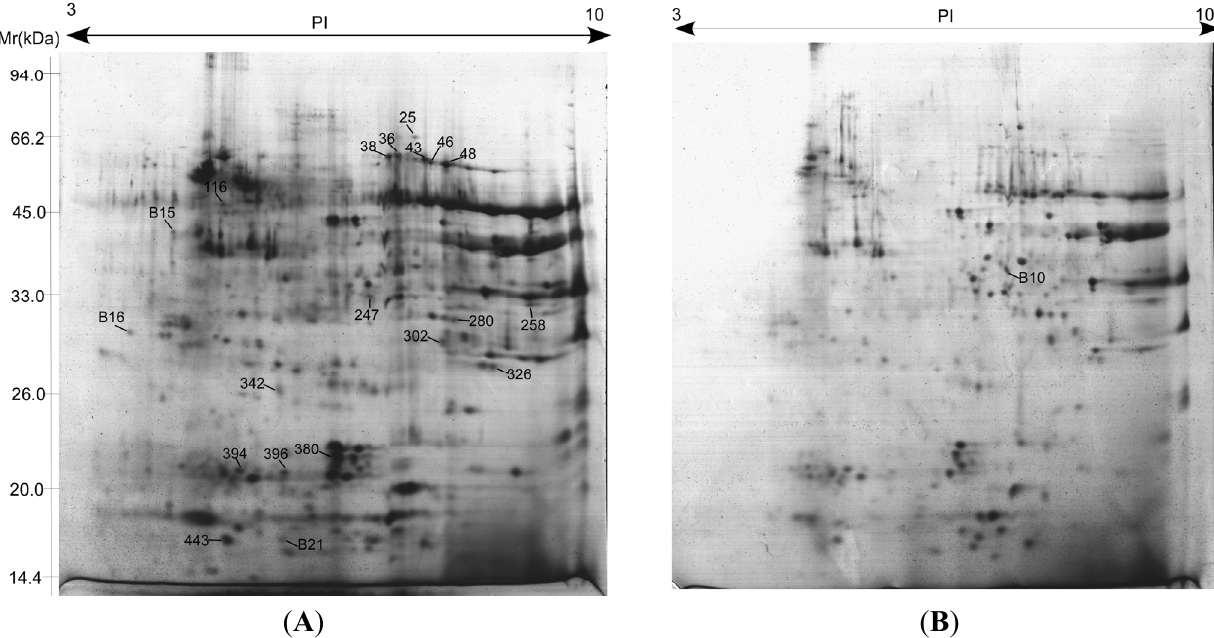
Figure 5. 2-DE patterns of albumins and globins from mature seeds of CS ( A ) and 3BS-8 ( B